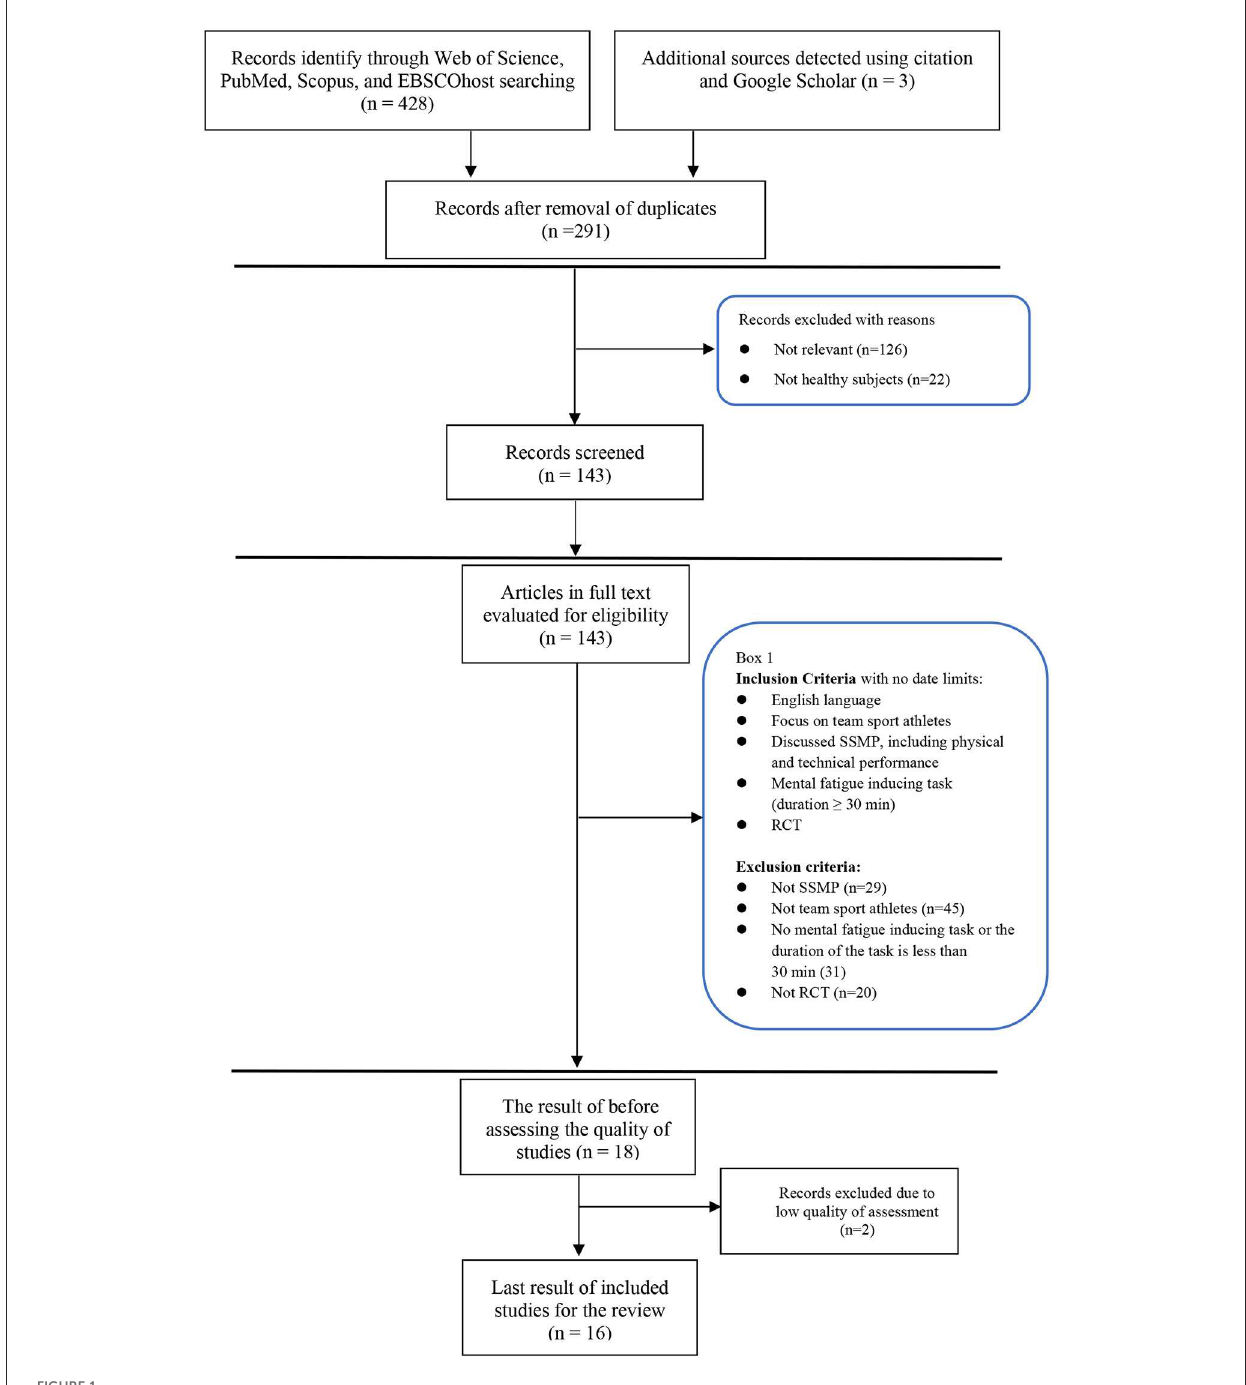
FIGURE1 PRISMA summary of the study selection